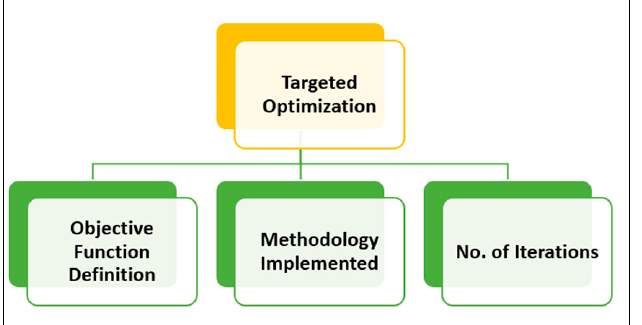
Figure 15. Major optimization elements.